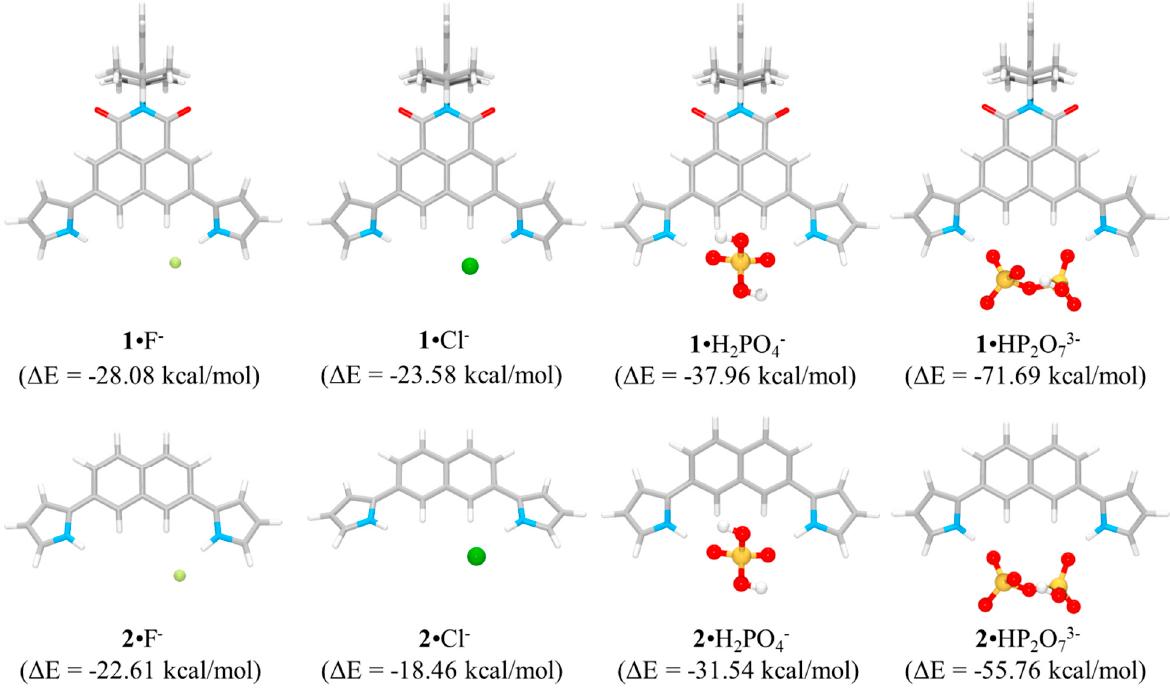
Figure 3. Optimized geometries of the complexes of receptors 1 and 2 with fluoride, chloride, dihydro- gen phosphate, and hydrogen pyrophosphate as computed in the gas phase and the corresponding calculated binding energies ( ∆ E) for the interactions of receptors 1 and 2 with the anions.